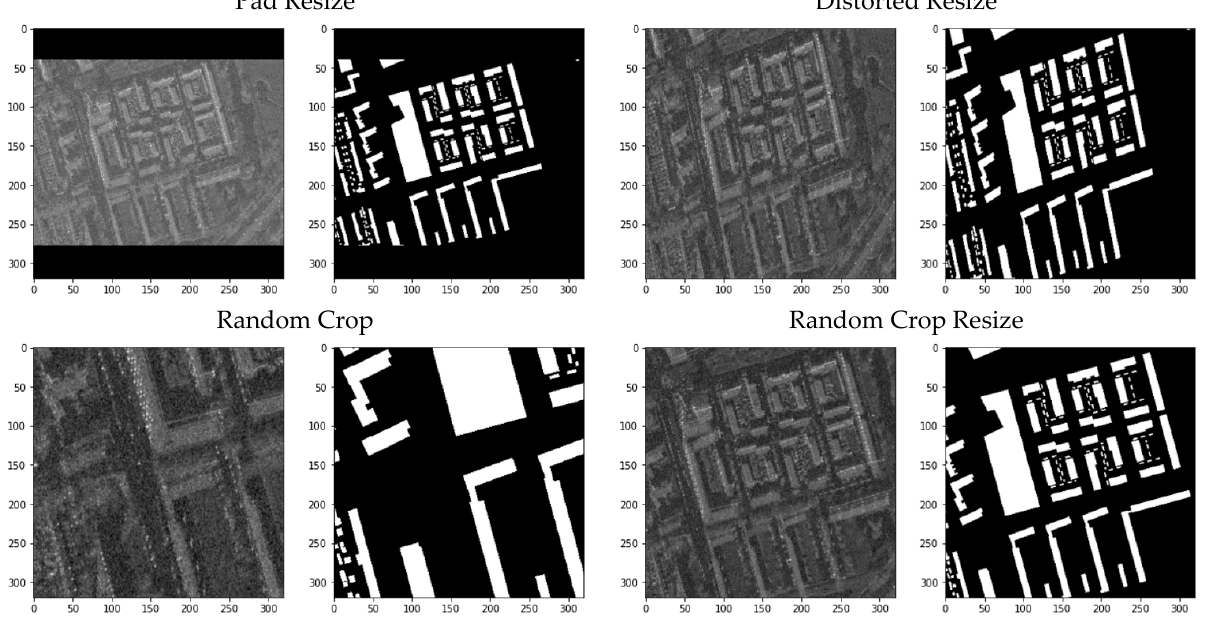
Figure 7. Reduce Transformations comparison.